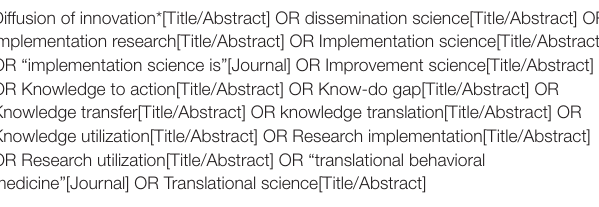
TABLE 2 | Other journals experts deemed important in view of identification of IS articles ( n =